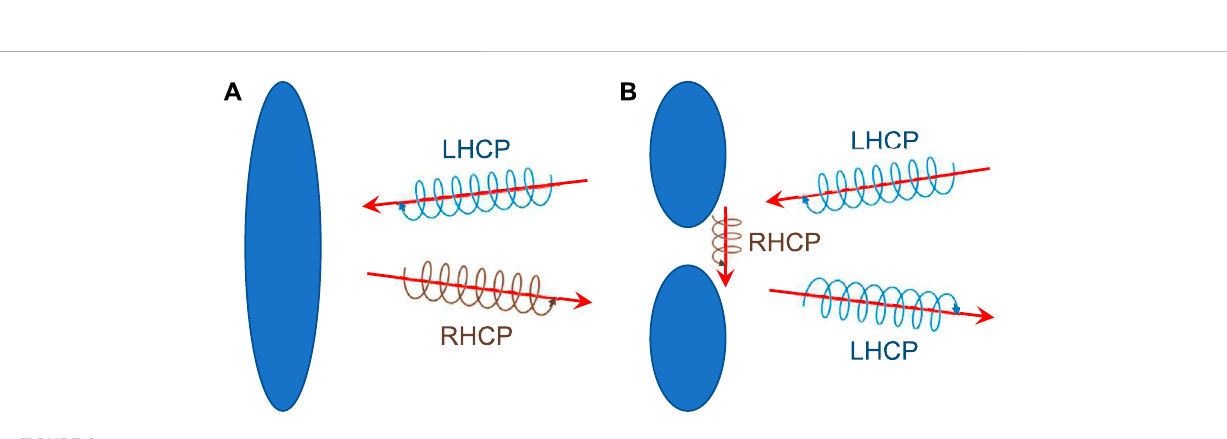
FIGURE 2 Schematic diagram of the re fl ection of a circularly polarized wave. The polarization of the re fl ected wave changes to the orthogonal direction relative to the incident wave. (A) Single scattering on the object. (B) Multiple scatterings between two spaced